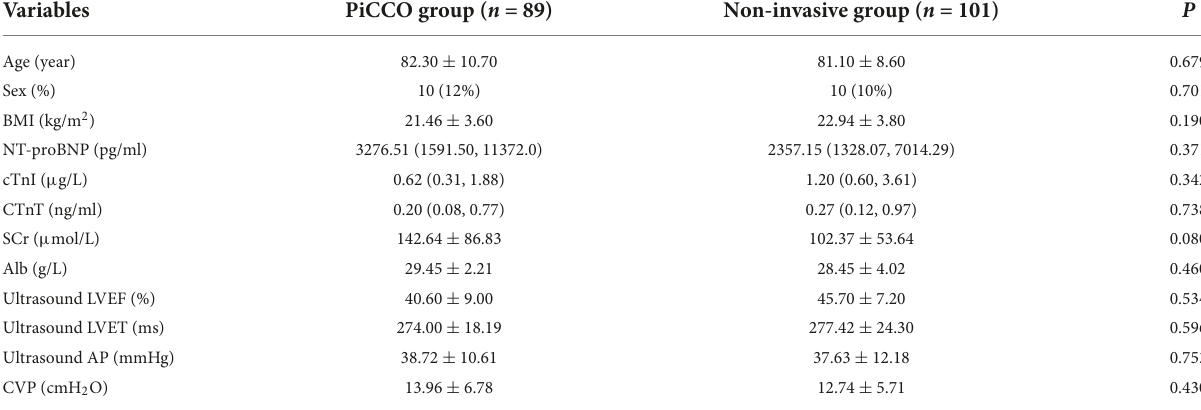
TABLE 1 Clinical data for PiCCO and non-invasive